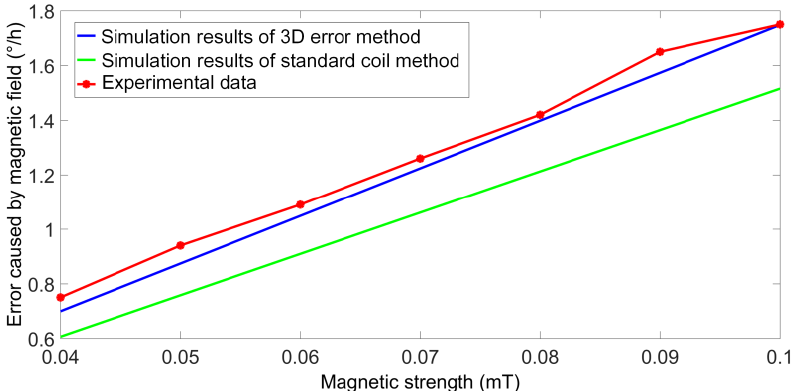
Figure 13. The comparison between the simulation results and the experimental results of the axial magnetic induced errors of the two error methods.